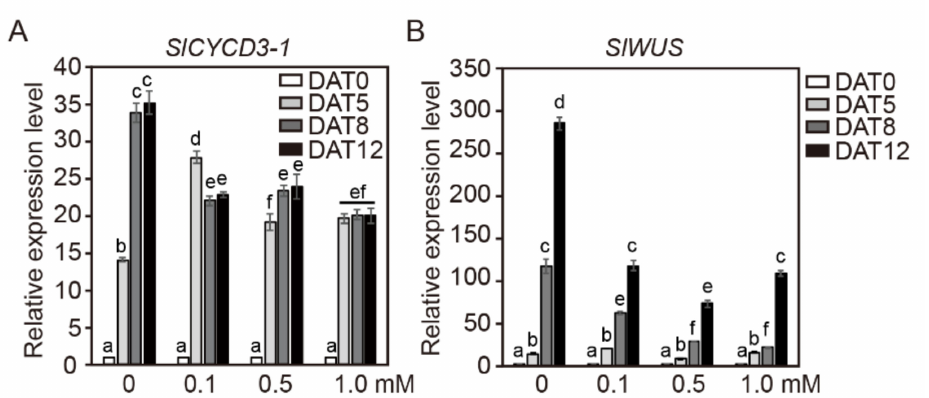
Figure 6. The relative expression levels of SlCYCD3-1 and SlWUS genes in cotyledon explants of tomato after NaB treatment. The relative gene-expression levels of SlCYCD3-1 ( A ) and SlYUC10 ( B ) genes in cotyledon explants of tomato cultured in shoot induction medium containing 0, 0.1, 0.5, and 1.0 mM of NaB. Data are representative of the results from three independent experiments. Error bars represent SD ( n = 3). Di ff erent letters on the bars indicate significant di ff erences between each treatment (ANOVA followed by a Turkey’s test, p < 0.05). DAT = day after